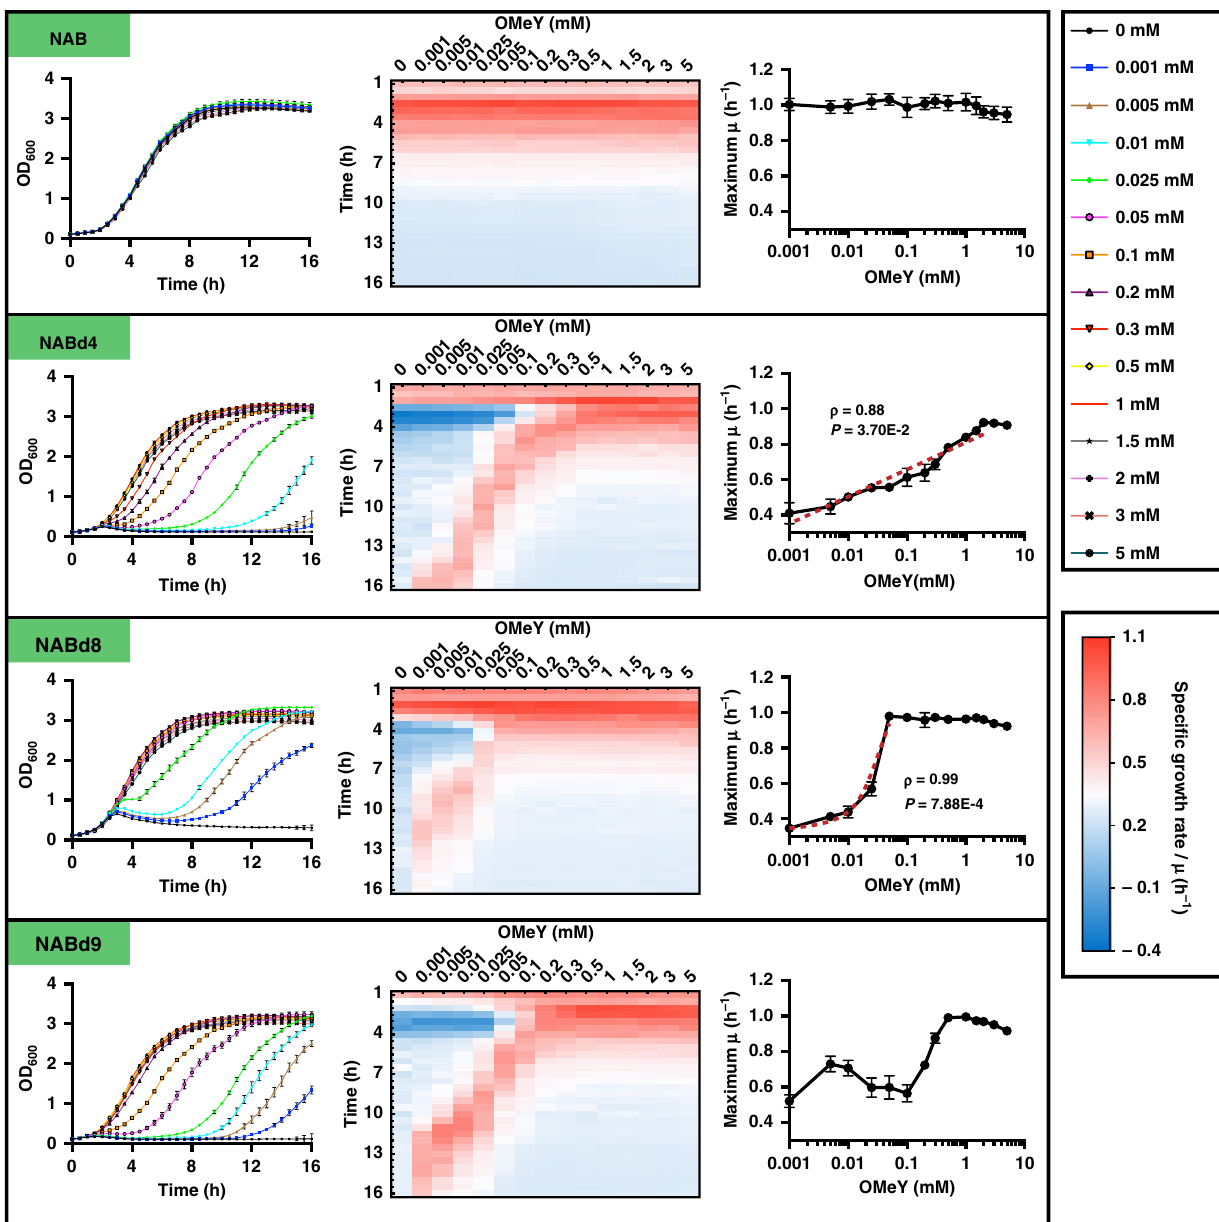
Fig. 4 Effects of different O -methyl-L-tyrosine (OMeY) concentrations on the growth of OMeY-dependent, engineered Bacillus subtilis strains. The growth curves of the four engineered strains (left panels). Speci fi c growth rates and maximum speci fi c growth rates of the engineered strains at different OMeY concentrations are shown in the middle and right panels, respectively. ρ , Pearson correlations; P , p -value. All the data displayed as the mean ± SD ( n = 4) of four biologically independent replicates. The statistical analysis was performed by one-sided t -test. Source data are provided as a Source data fi